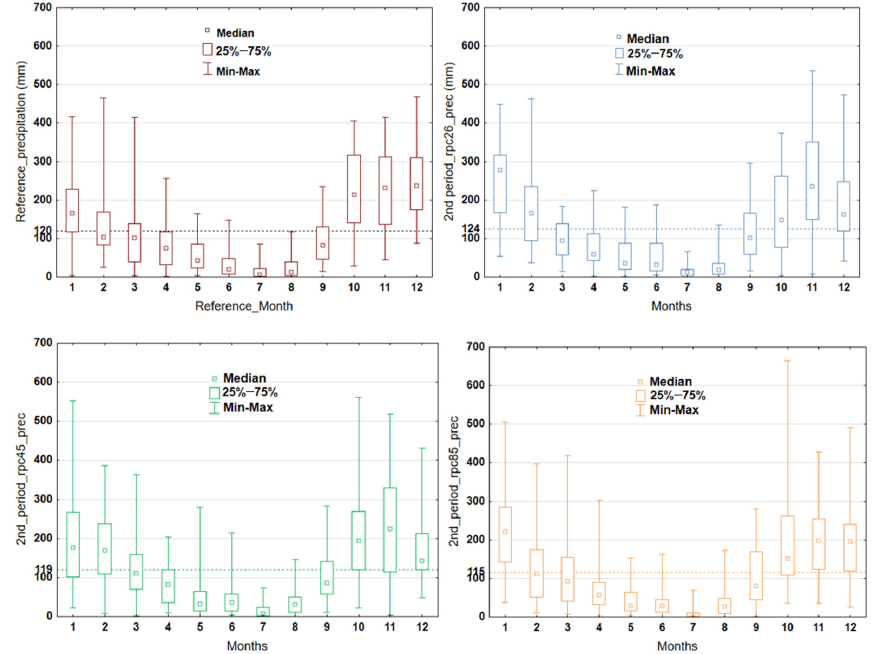
Figure 10. Distribution of the variations in the maximum monthly precipitation values for the reference period and the second-period climate scenarios (2069–2098). Dashed lines are the average values of the projected data.